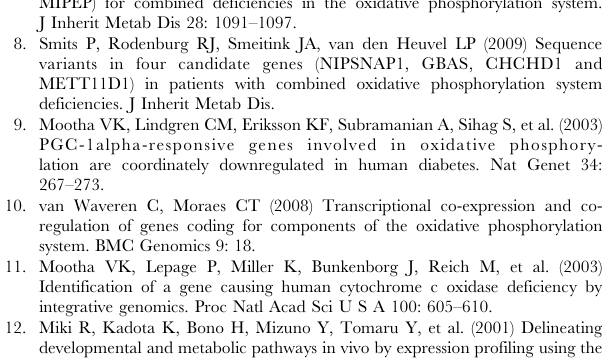
simultaneously with RNA. Error bars represent standard deviation (n =3). *, P , .05 (two-tailed unpaired t-test). Found at: doi:10.1371/journal.pgen.1000590.s003 (0.33 MB PDF) Figure S4 Silencing SLIRP does not affect UQCRC1 , TFAM , TFB1M , or TFB2M expression. mRNA levels of UQCRC1 , TFAM , TFB1M , and TFB2M measured by qPCR from the samples described in Figure S2. SLIRP_A and SLIRP_B are independent shRNA hairpins corresponding to Figure S2 samples TRCN0000152814 and TRCN0000154330, respectively. Results were normalized to the expression of HPRT as an endogenous control. Values are reported as average ratio over shGFP; error bars indicate standard deviation (n= 3). Table S1 Microarray data sets used in expression screening. Each microarray data set is listed with its GEO accession number, the data set title and Affymetrix platform. Mouse platforms are preceded by ‘‘MG’’ while human platforms are preceded by ‘‘HG’’. Each data set is also listed with its ‘‘weight’’ representing the intra-correlation of either the OxPhos gene set or cholesterol pathway gene set (see Materials and Methods). Table S2 The cholesterol pathway gene set used in expression screening. Genes directly involved in cholesterol biosynthesis were mapped to each Affymetrix platform. In cases where multiple probesets match a gene, we chose the probeset exhibiting the least cross-hybridization at the sequence level according to Affymetrix annotations. Table S3 Results of the cholesterol biosynthesis expression screen. The top 41 genes resulting from the cholesterol expression screen sorted by their probability of co-expression with the cholesterol gene set after data integration of all human and mouse microarray data sets (‘‘Human&Mouse’’ column). We also include the probabilities resulting from data integration of each platform alone or of each species, human or mouse, alone. The Affymetrix probeset yielding the highest probability of co-expression for each gene is given for each platform. Genes are identified by their NCBI homologene ID (HID). Cholesterol pathway genes used as the query gene set are identified by a ‘‘1’’ in the ‘‘Cholesterol’’ column.